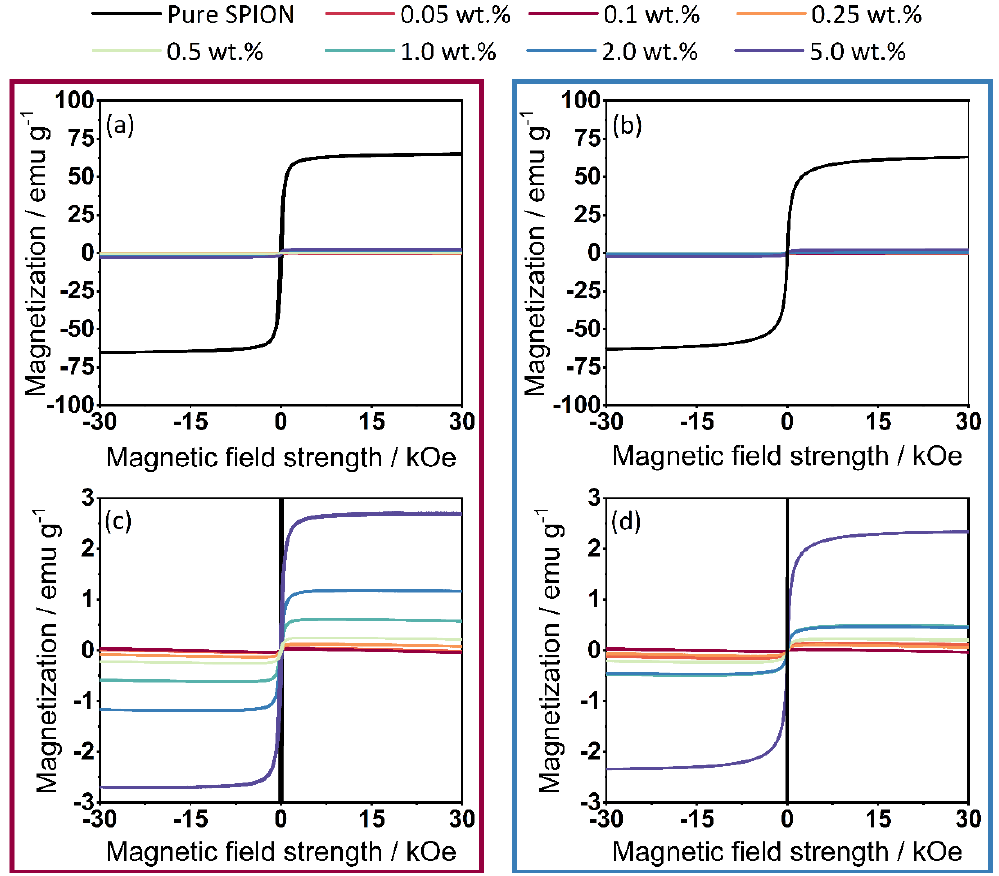
Figure 9. Measurement results from VSM. ( a ) Results from the complete measurement spectrum of γ -Fe 2 O 3 , ( b ) Results from the complete measurement spectrum of Fe 3 O 4 , ( c ) Magnification; ( d ) Magnification of the magnetization—(values displayed in cgs units).